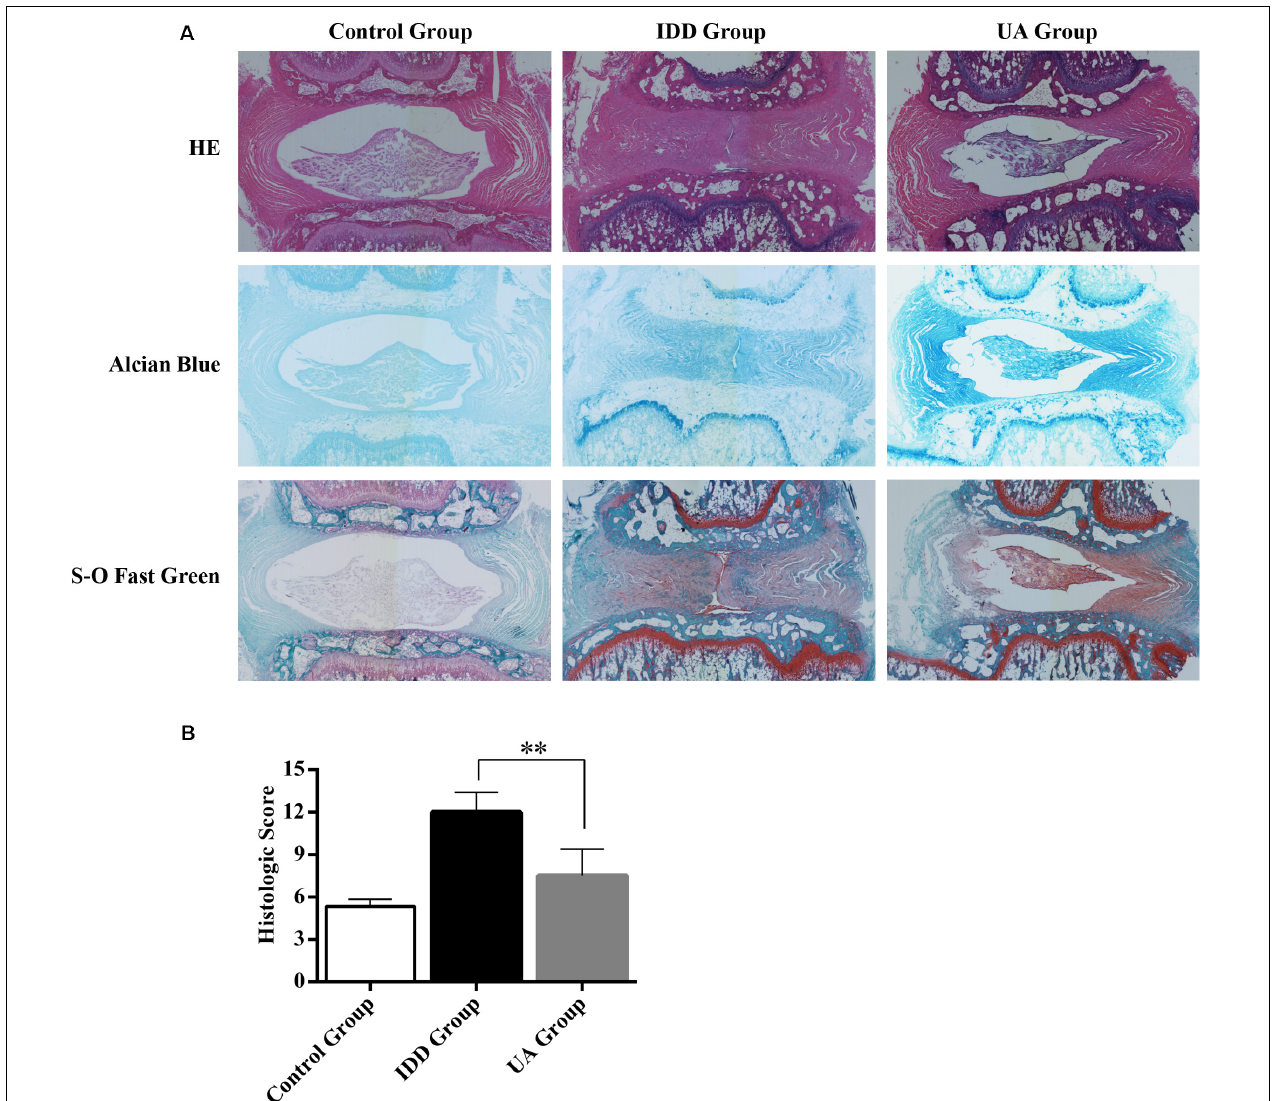
FIGURE 6 | Representative histological sections of the intervertebral disc. (A) HE staining, Alcian Blue staining, and Safranin O-Fast Green staining were performed 4 weeks after surgery. The stained images were magnified 40 × . N = 10 per group. (B) Histologic score of the disc in each group. The data represent the means ± SD. ∗∗ P < 0.01 compared with the IDD